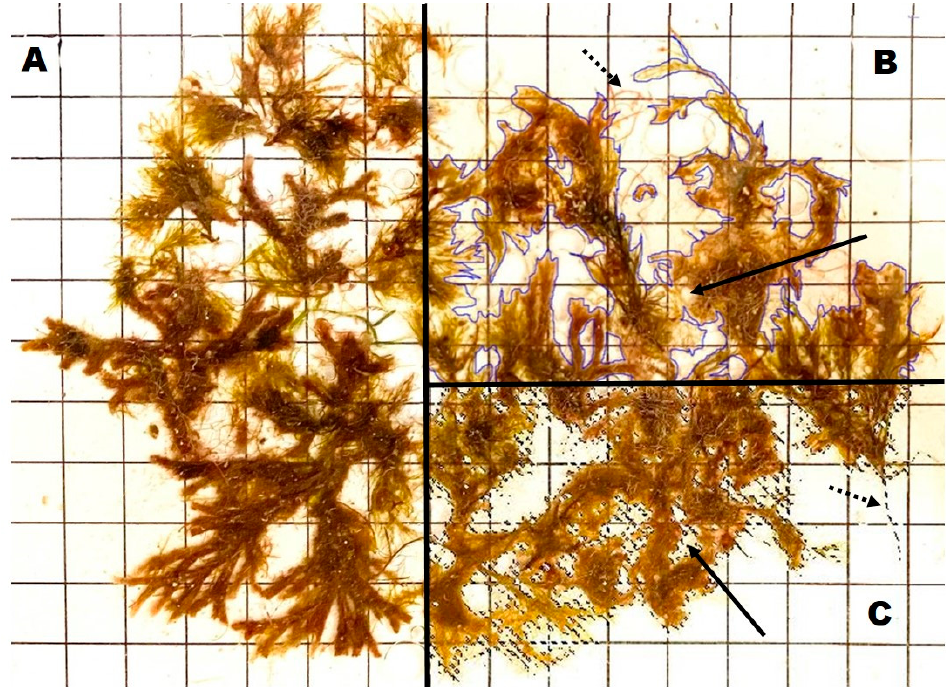
Figure 1. Flattened Cystoseira sp. specimen ( A ) with manual selection using ImageJ (blue lines, ( B )) and automated selection using Photopea (dashed lines, ( C )). Bold arrows highlight included ( B ) and excluded ( C ) areas within the selected area. Dashed arrows highlight delicate algal filaments that are not included using ImageJ ( B ), but are automatically selected using Photopea ( C ). Table 1. Mean surface area and mean time saved to determine the surface area of Cystoseira sp. ( Cys sp.) and Phyllophora crispa ( P. crispa ) samples ( n = 6) using ImageJ and